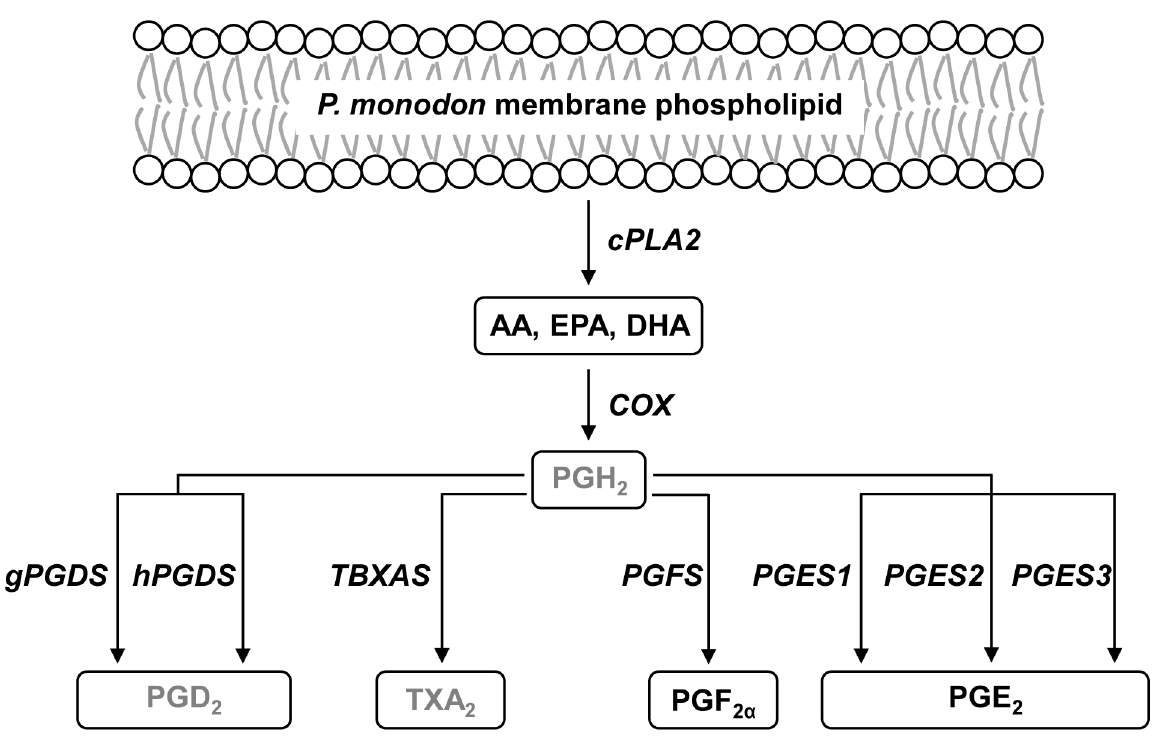
Figure 9. The proposed prostanoid biosynthesis pathway in P. monodon . PUFAs, prostaglandins and full-length prostanoid biosynthesis genes identified in this study (black) were used to outline the P. monodon prostanoid pathway based on the previously published pathway in mammals. Prostanoids that have yet to be identified in P. monodon are shown in gray. doi: